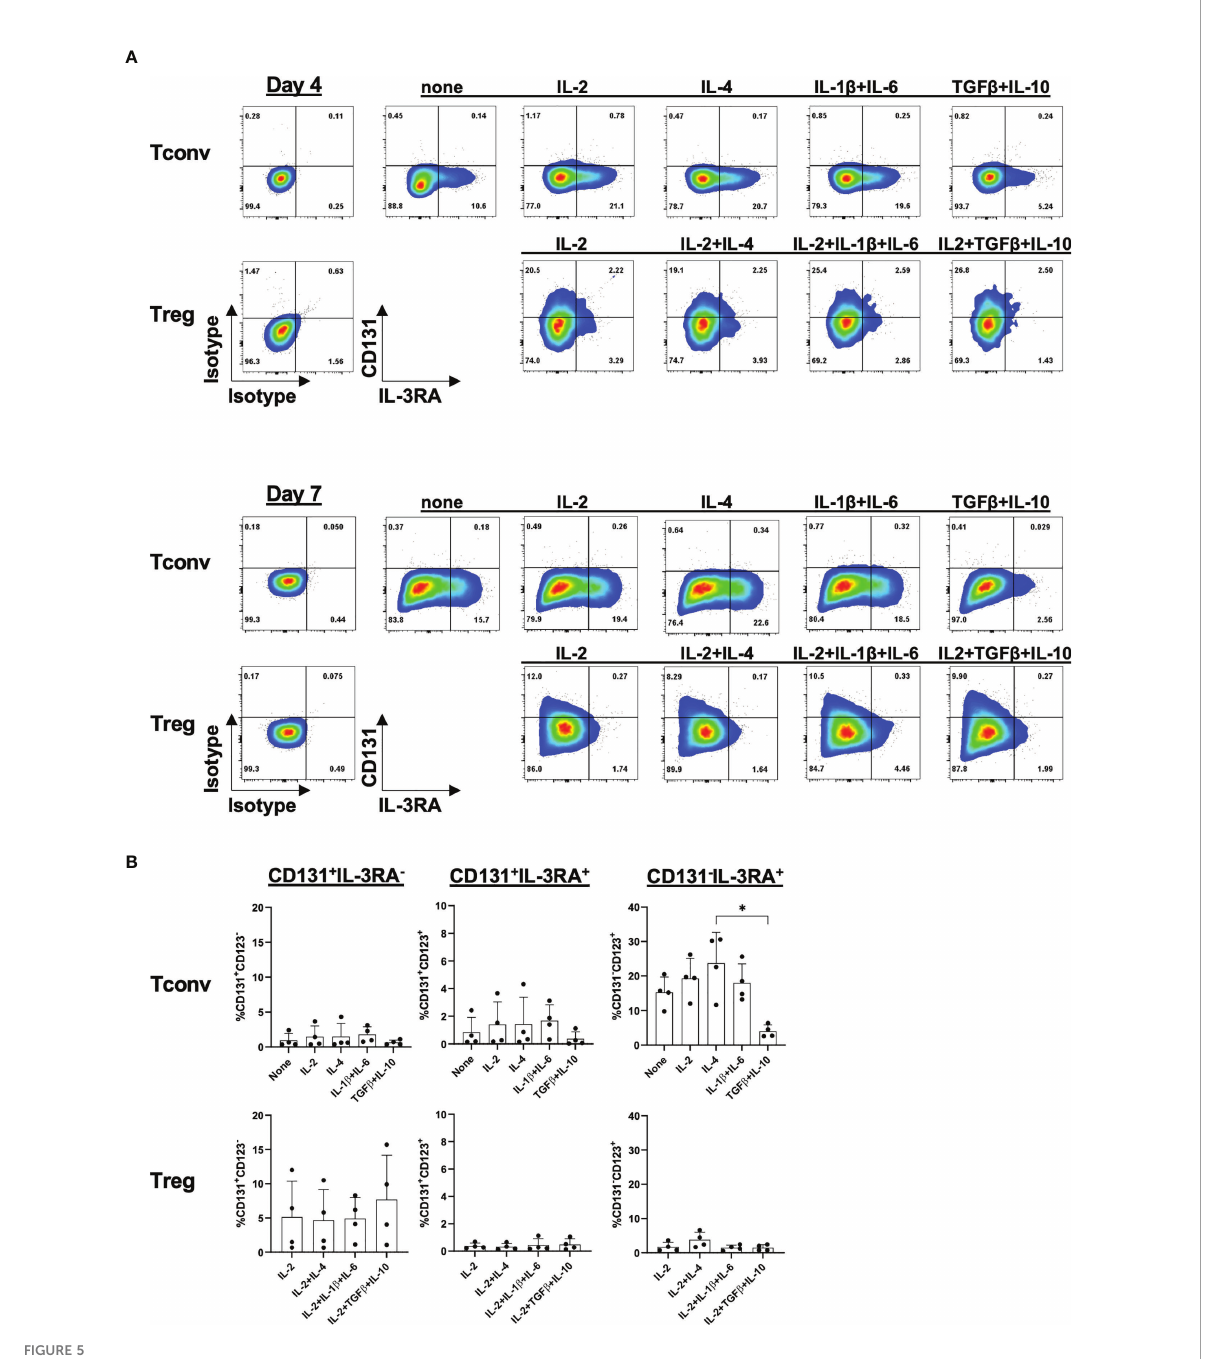
FIGURE 5 Cytokine-mediated regulation of CD131 and IL-3RA expression. Surface CD131 and IL-3RA expression was studied in CD4 + CD25 - Tconvs or Tregs cultured for 4 or 7 days with 5µg/ml anti-CD3mAb, 1µg/ml CD28 mAb and different cytokines as indicated (IL-4, IL-6, IL-1 b and IL-10: 25ng/ml, TGF b : 10ng/ml). Additional 100U/ml IL-2 was added to all Treg cultures or 25U/ml IL-2 to Tconv where indicated. (A) One representative donor out of four is shown. (B) Mean ± SD is shown for n=4 independent donors after 7 days of stimulation. Signi fi cance was calculated using a Friedman test with Dunn ’ s multiple comparisons test. Only p-values lower than 0.05 are shown. * for P ≤